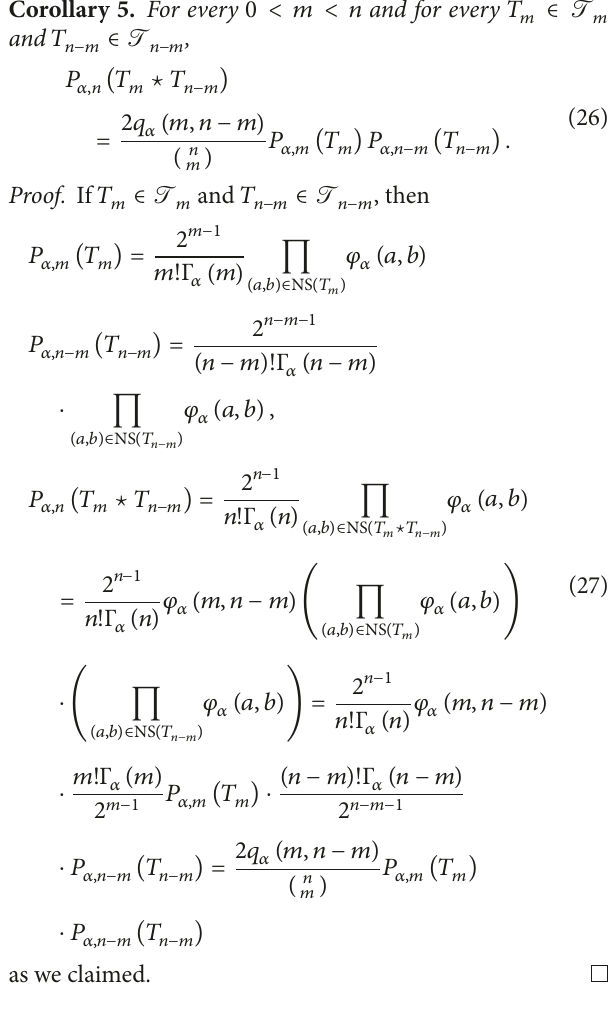
Figure 5: The cladogram